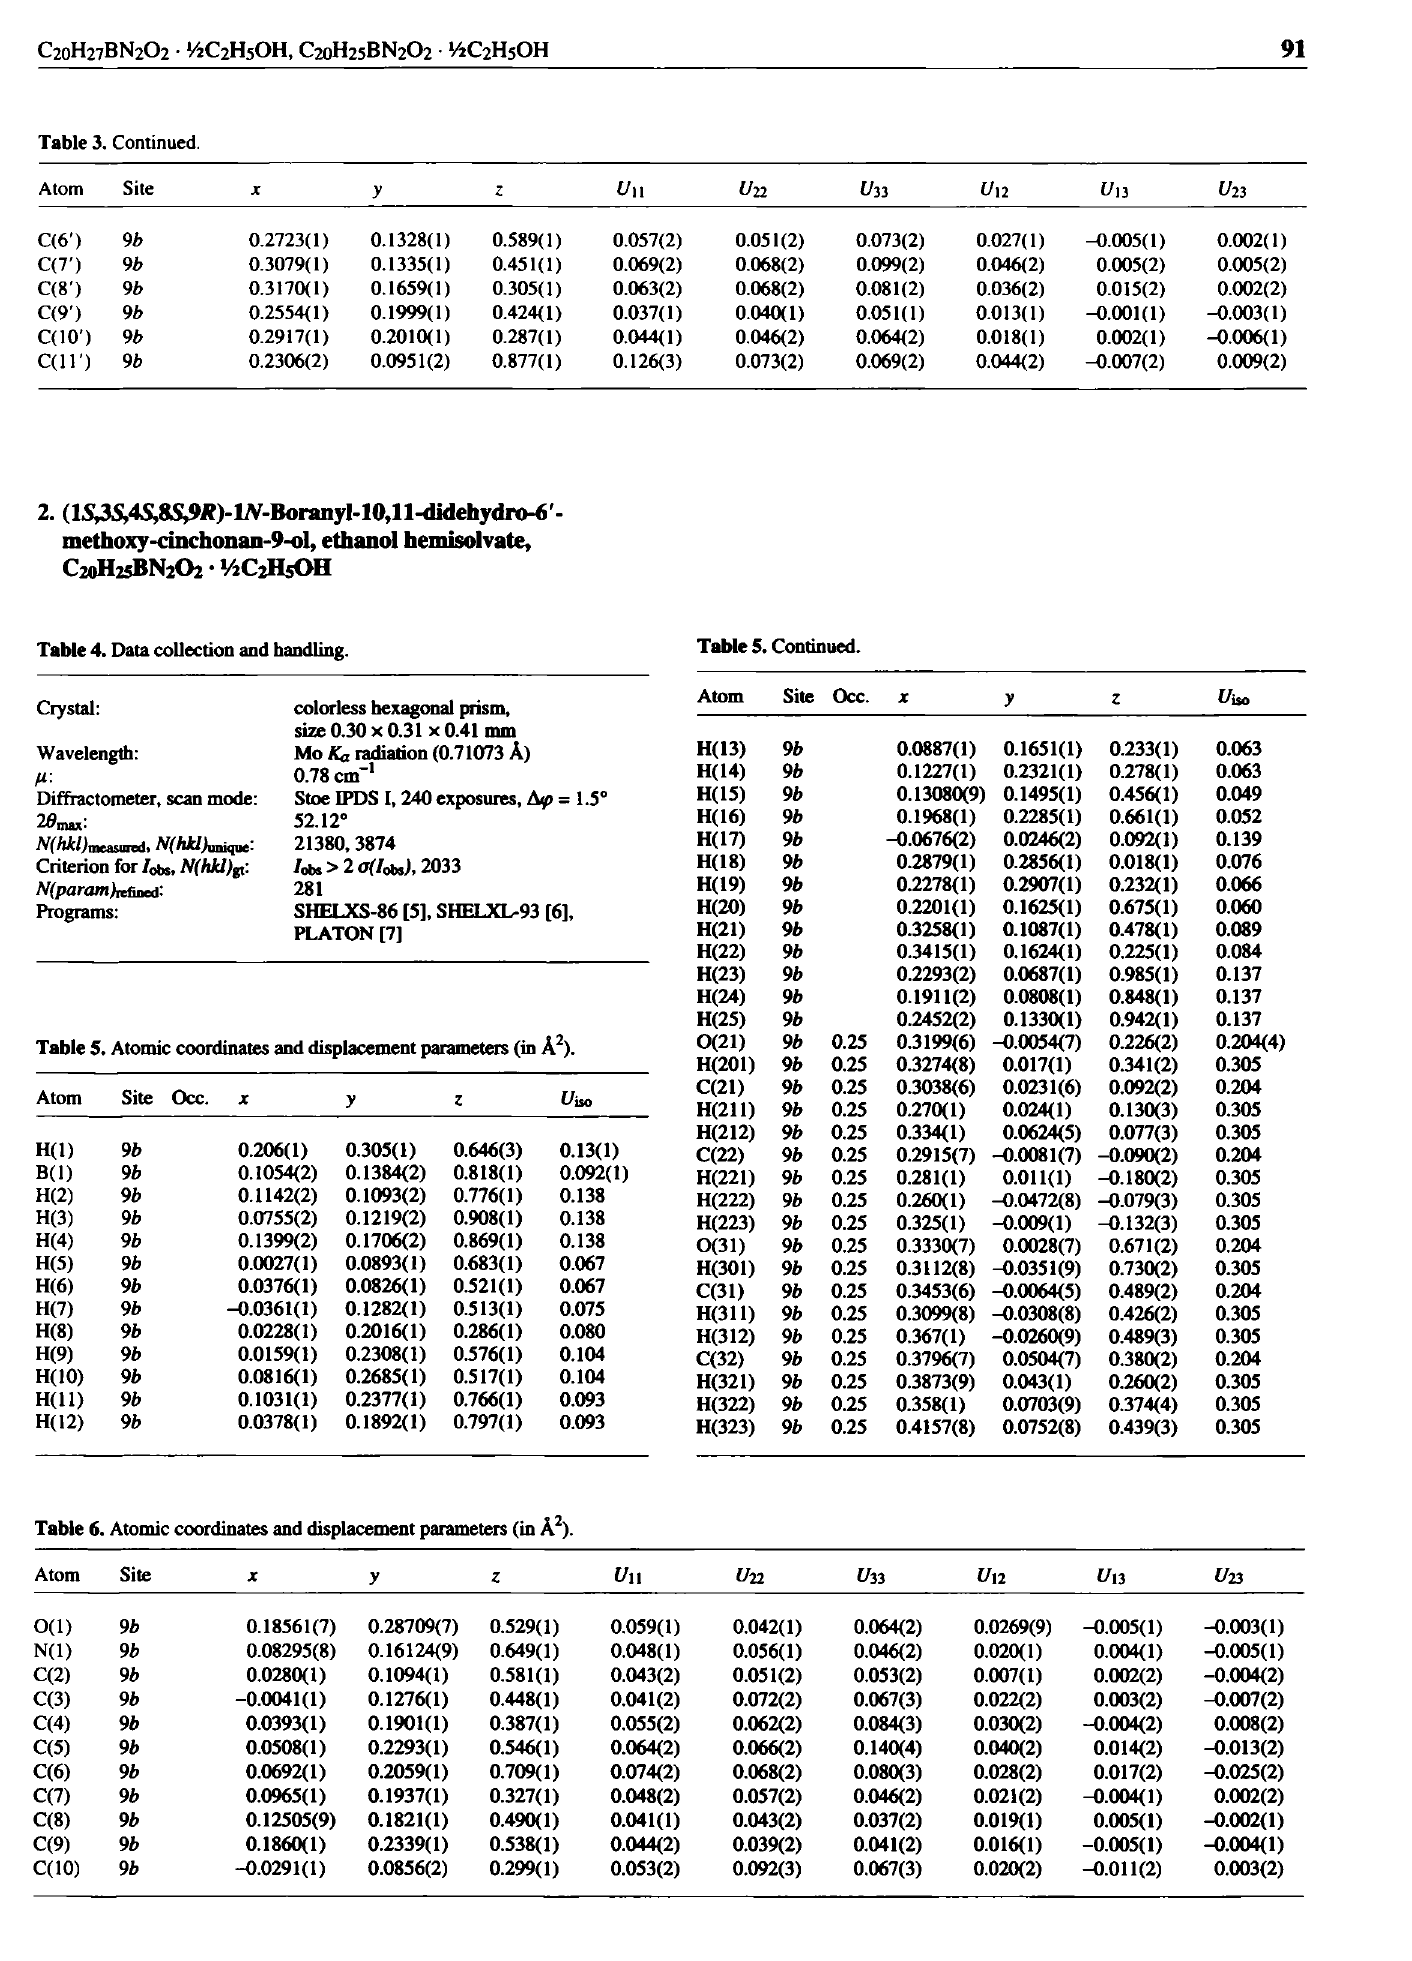
Table 6. Atomic coordinates and displacement parameters (in A 2